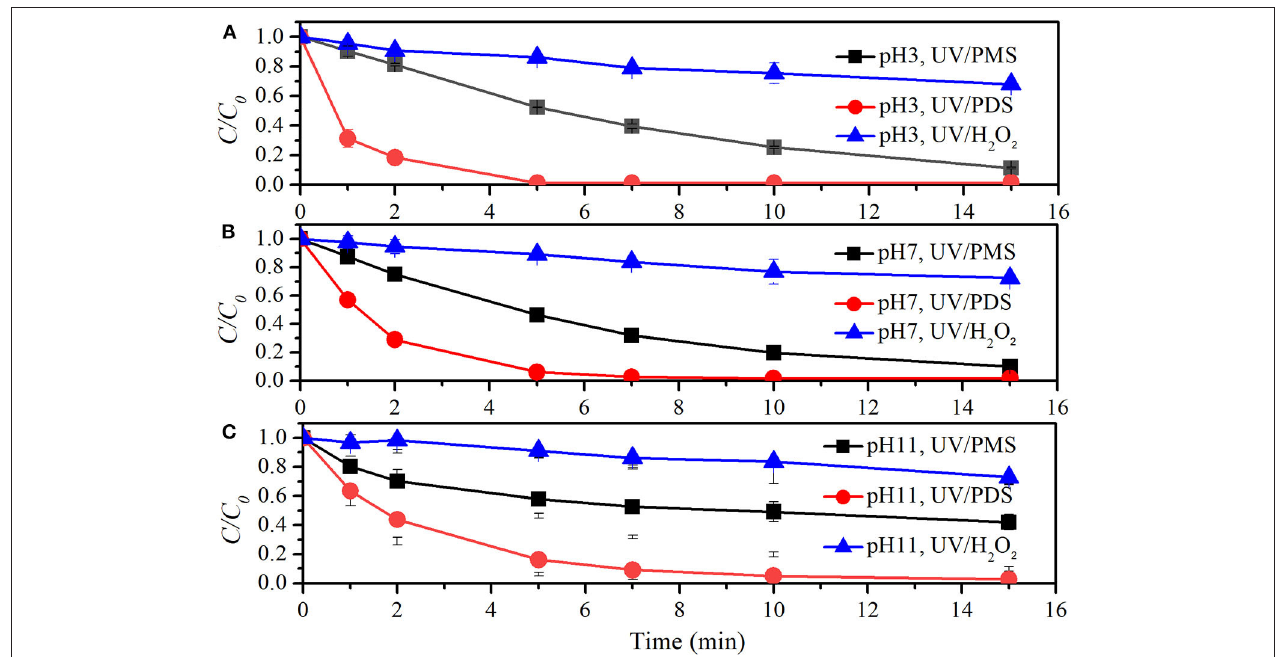
constant of radical and TCM) to k radical,PDS (rate constant of radical and PDS) were 3.2, 4.5, and 7.5 for SO ·− , HO · , and Cl · , 4 respectively. The ratios reflected the radical efficiency toward TCM against PDS, similar to the radical participation ratio (RPR) reported in UV/PMS (Guan et al., 2018). In the presence of chloride, SO ·− was fast converted into Cl · and Cl ·− under acidic 4 2 conditions and increasing pH would lead to conversion of Cl · to HO · (Lutze et al., 2015; Guan et al., 2018). This would lead to the declined TCM degradation as pH increased from 7 to 11. The variation of TCM destruction with pH was similar to the trend of 2-methylisoborneol and geosmin removal vs. pH, which was ascribed to the distribution of phosphate ions (Xie et al., 2015).